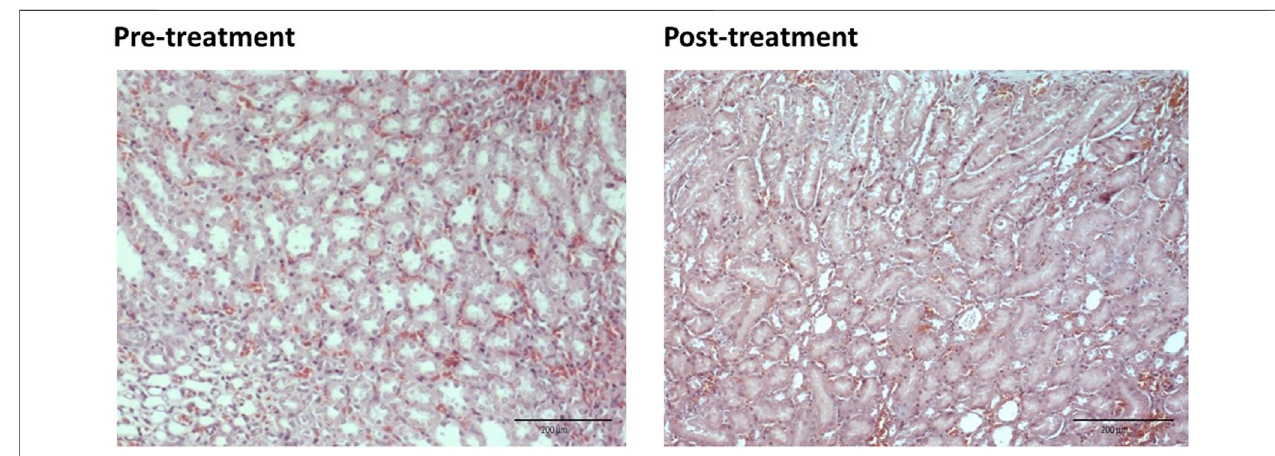
FIGURE 6 | Pre-treatment with EBN 500mg/kg and GTN-mild ATN.